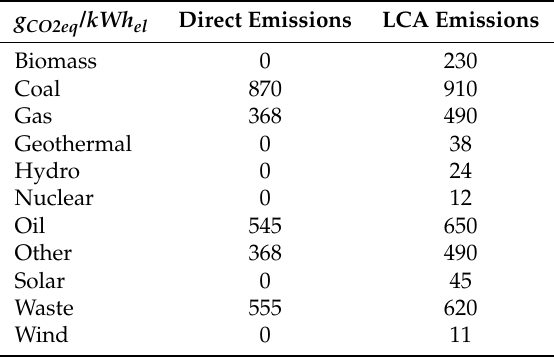
Table 1. Emission factors for electricity generation from different sources [31,32].